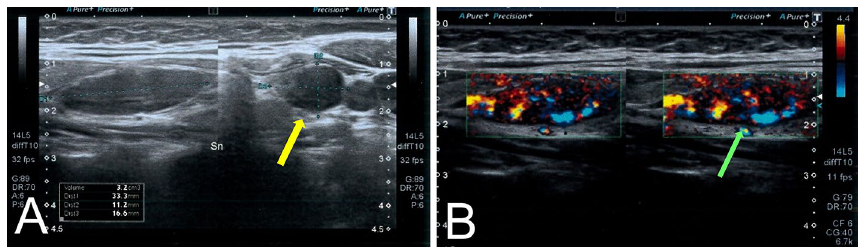
Fig. 1 Ultrasound ( A ) showing hyperplastic parathyroid tissue in the lower left parathyroid lodge (yellow arrow) with contextual vascularization at color-power-Doppler (green arrow) ( B )